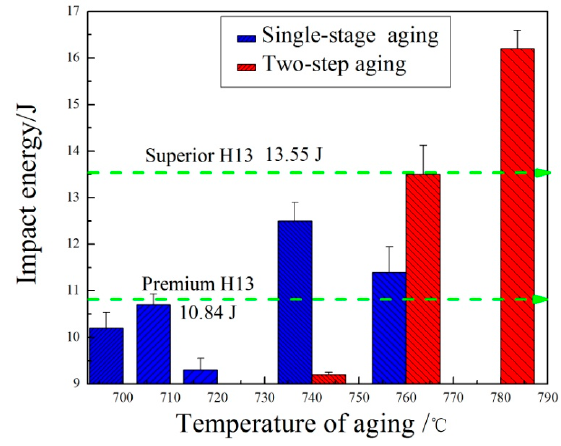
Figure 11. Impact energy of specimens aged with different aging heat treatment processes.